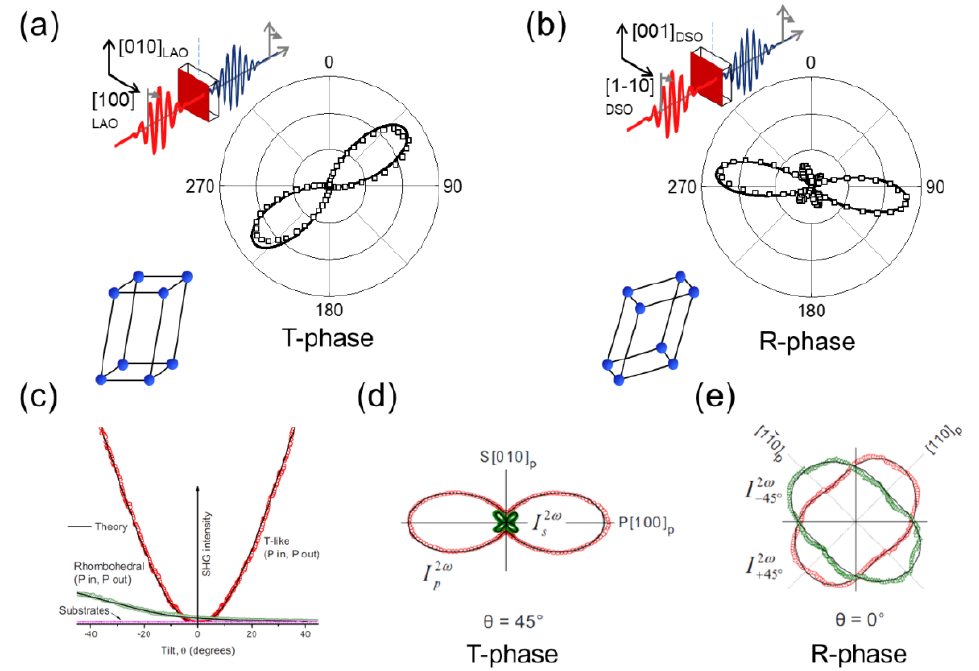
Figure 10. SHG to distinguish different monoclinic phases. ( a , b ) SHG anisotropy measurements collected at normal incidence for T- and R-phase, respectively. Reproduced with permission from [88] Copyright Wiley-VCH Verlag GmbH and Co. KGaA, 2015. ( c ) SHG intensity for different BFO films at different angles of incidence. ( d , e ) Polarizer measurements allow distinguishing the two